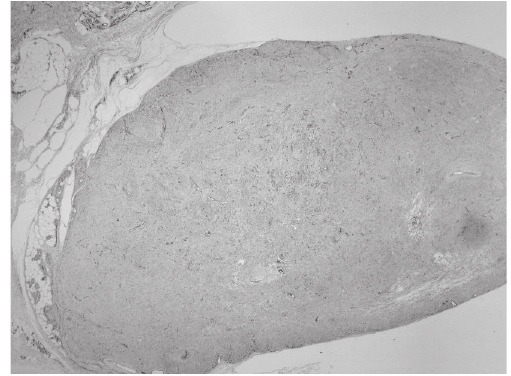
Figure 2: A low magnification histology slide of cavernous-type an- gioleiomyoma of the patient.